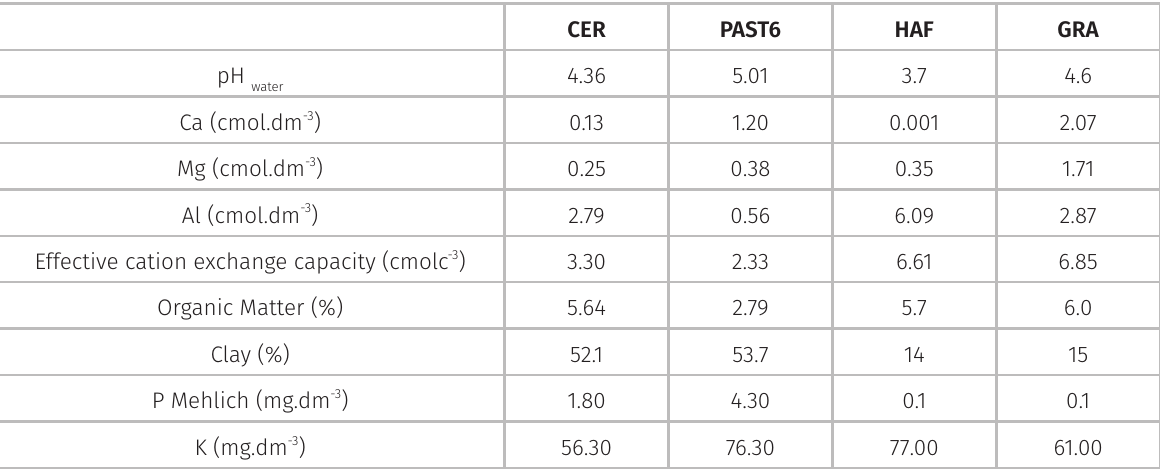
Table I. Soil chemical and physical attributes at the four study sites. CER: Savanna Tall Woodland – Cerradão. PAST6: Pasture (Cerrado biome). HAF: Upper montane Atlantic Forest. GRA: Grassland (Atlantic forest